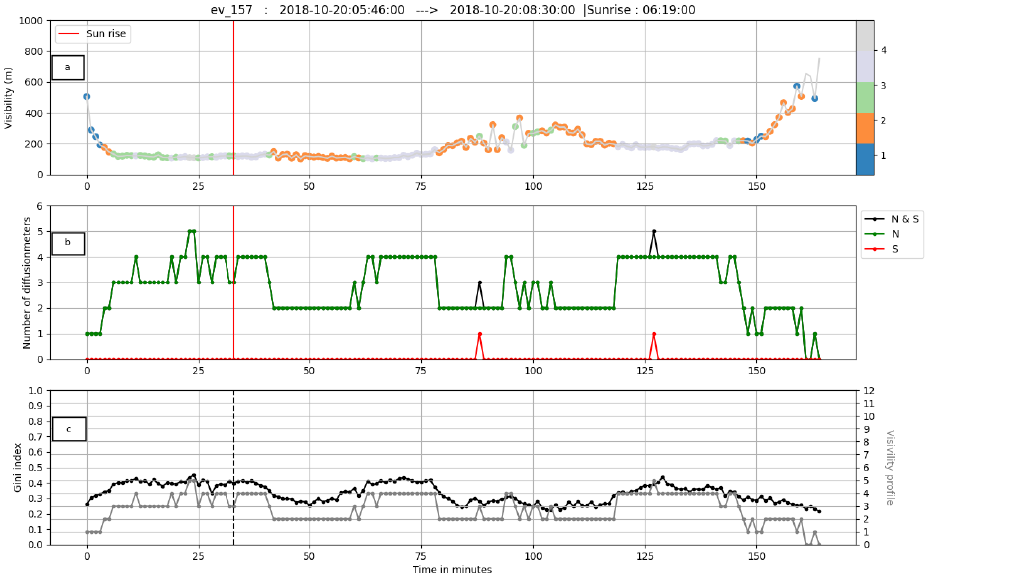
Figure 13. Same as Figure 12 except for an event localised in the northern side of Paris-CdG